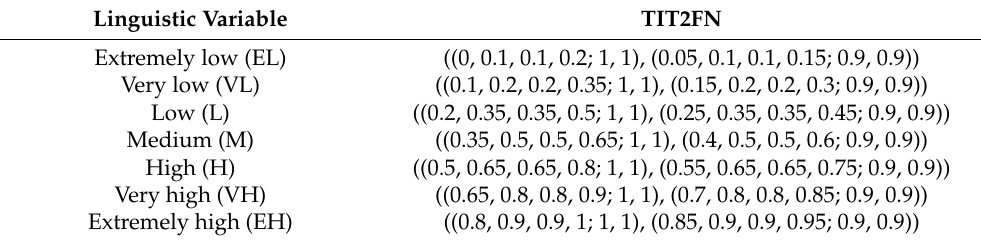
Table 1. Correspondence between linguistic variables and TIT2FN. Linguistic Variable TIT2FN Extremely low